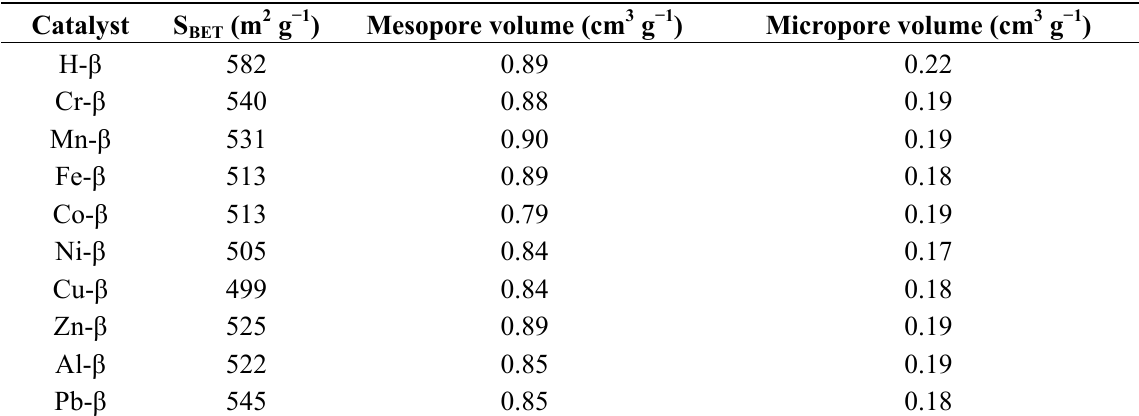
Table 2. Surface properties of metal exchanged β zeolites.